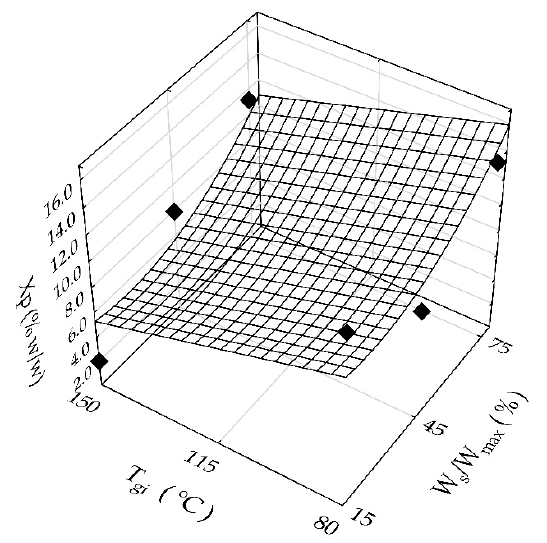
Figure 2. Qualitative surface plot showing the effects of drying variables W s /W max and T gi on product moisture content (Xp) of the dried rosemary extract.